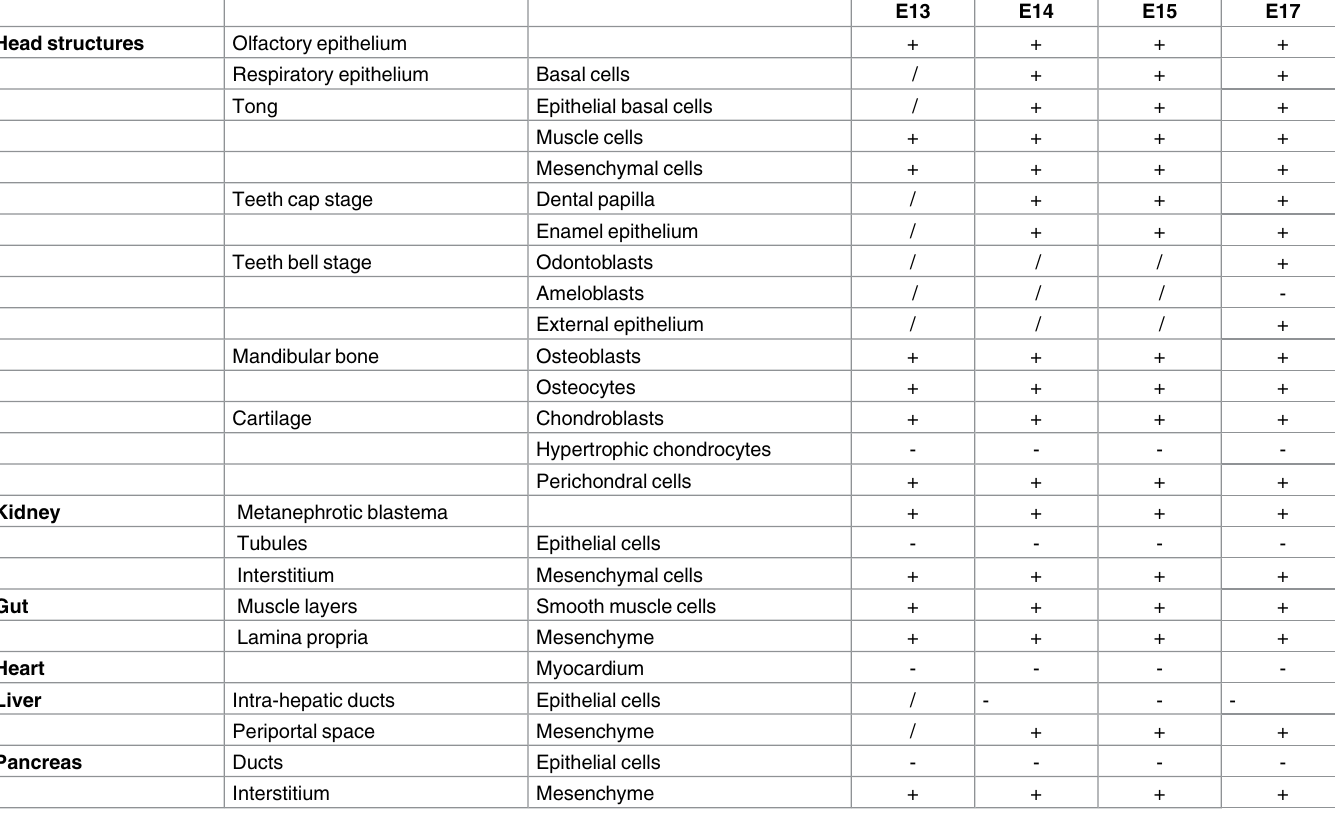
Table 2. AC3 detection in primary cilia of mouse developing organs. Head